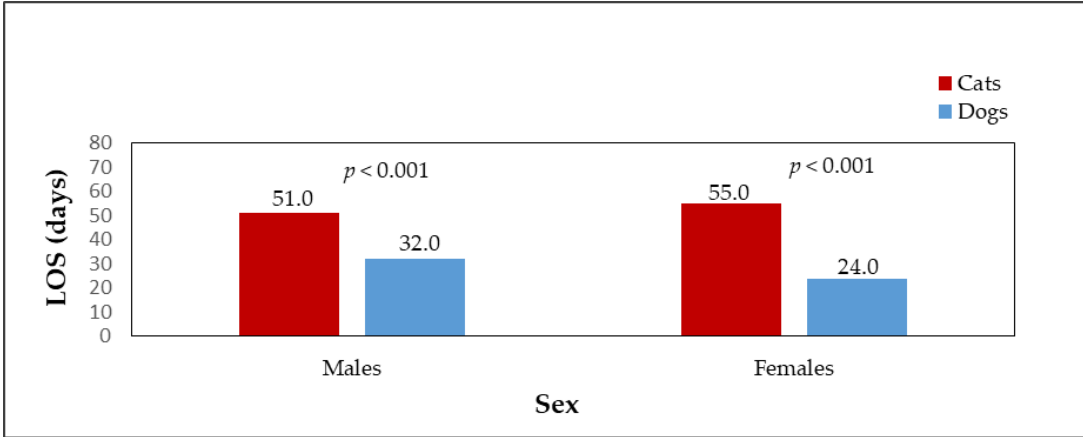
Figure 2. The median LOS of adopted dogs (n = 1073) and cats (n = 367) in sex categories.